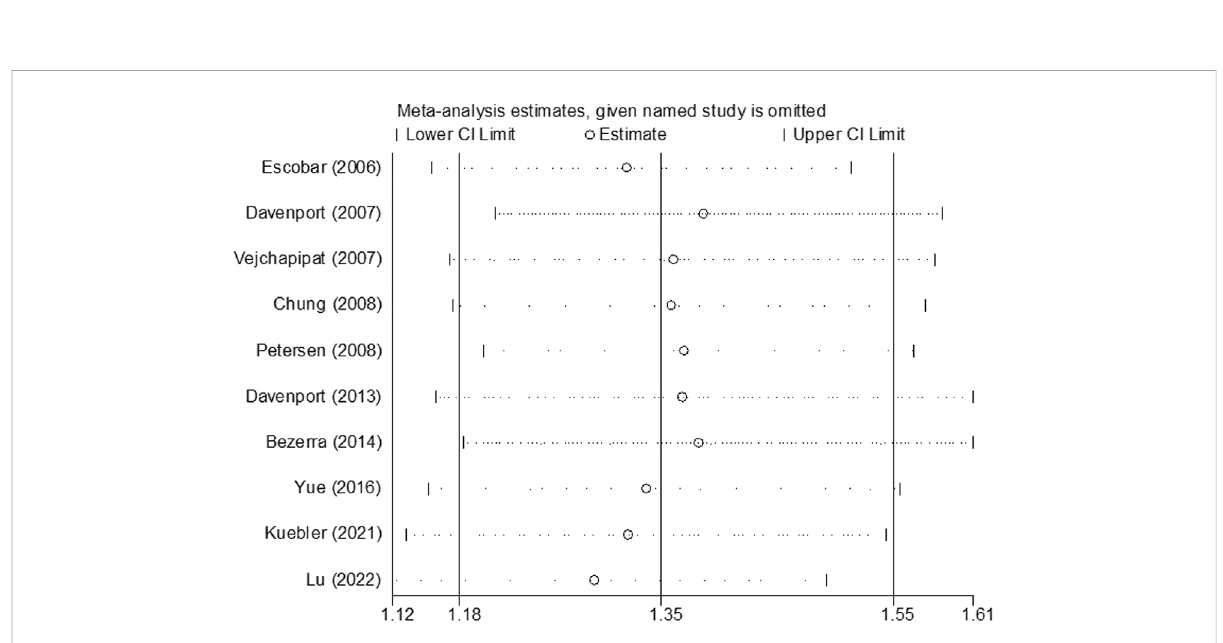
FIGURE 8 The result of sensitivity analysis regarding the assessment of JCR at 6 months. JCR, jaundice clearance